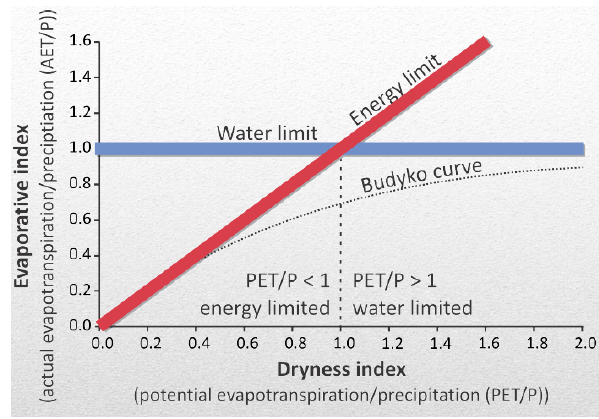
Figure A1. The Budyko curve. The water limit (ET = P ) is shown; a site cannot plot above the blue line unless there is input of wa- ter beyond precipitation. The energy limit (ET = PET) is shown; a site cannot plot above the red line unless precipitation is being lost from system by means other than discharge (adapted from Creed and Spargo, 2012a).